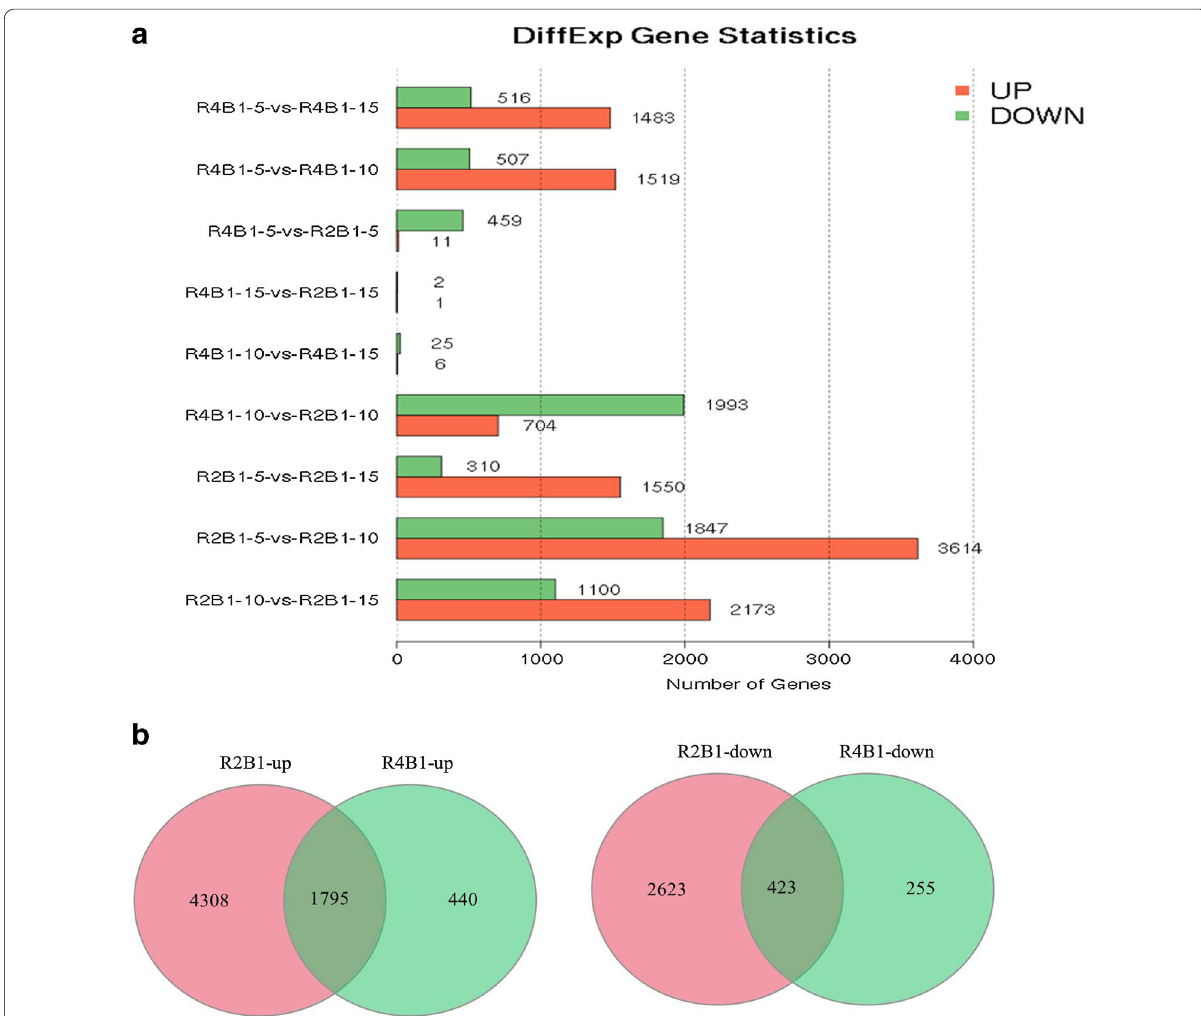
Fig. 1 a Statistical results of differentially expressed genes (DEGs) among different stages and treatments and b Venn diagrams of DEGs that were significantly (left) up-regulated and (right) down-regulated after R2B1 and R4B1